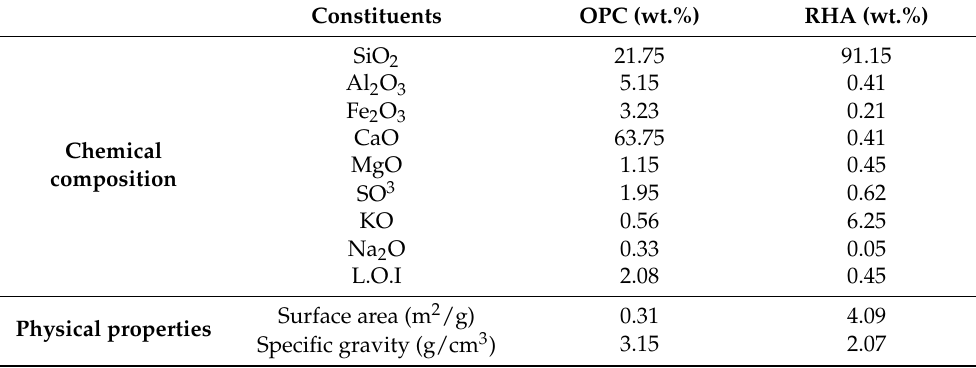
Table 1. Physical characteristics and oxide composition of RHA and OPC [31,32].